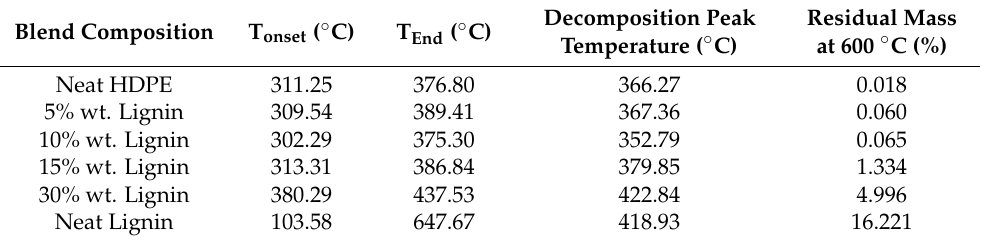
Figure 6. DTGA curves of different blends of HDPE and lignin. Table 4. TGA test